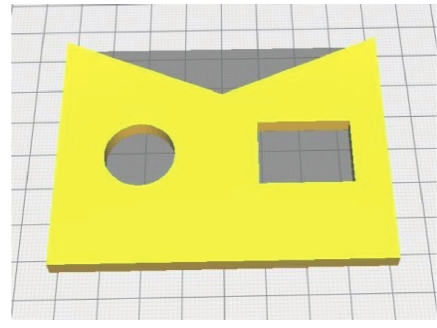
Figure 8: Testing model.